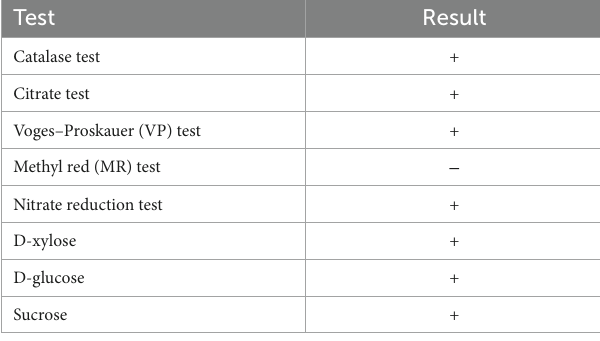
TABLE 2 Biochemical and physiological tests of Y17B.